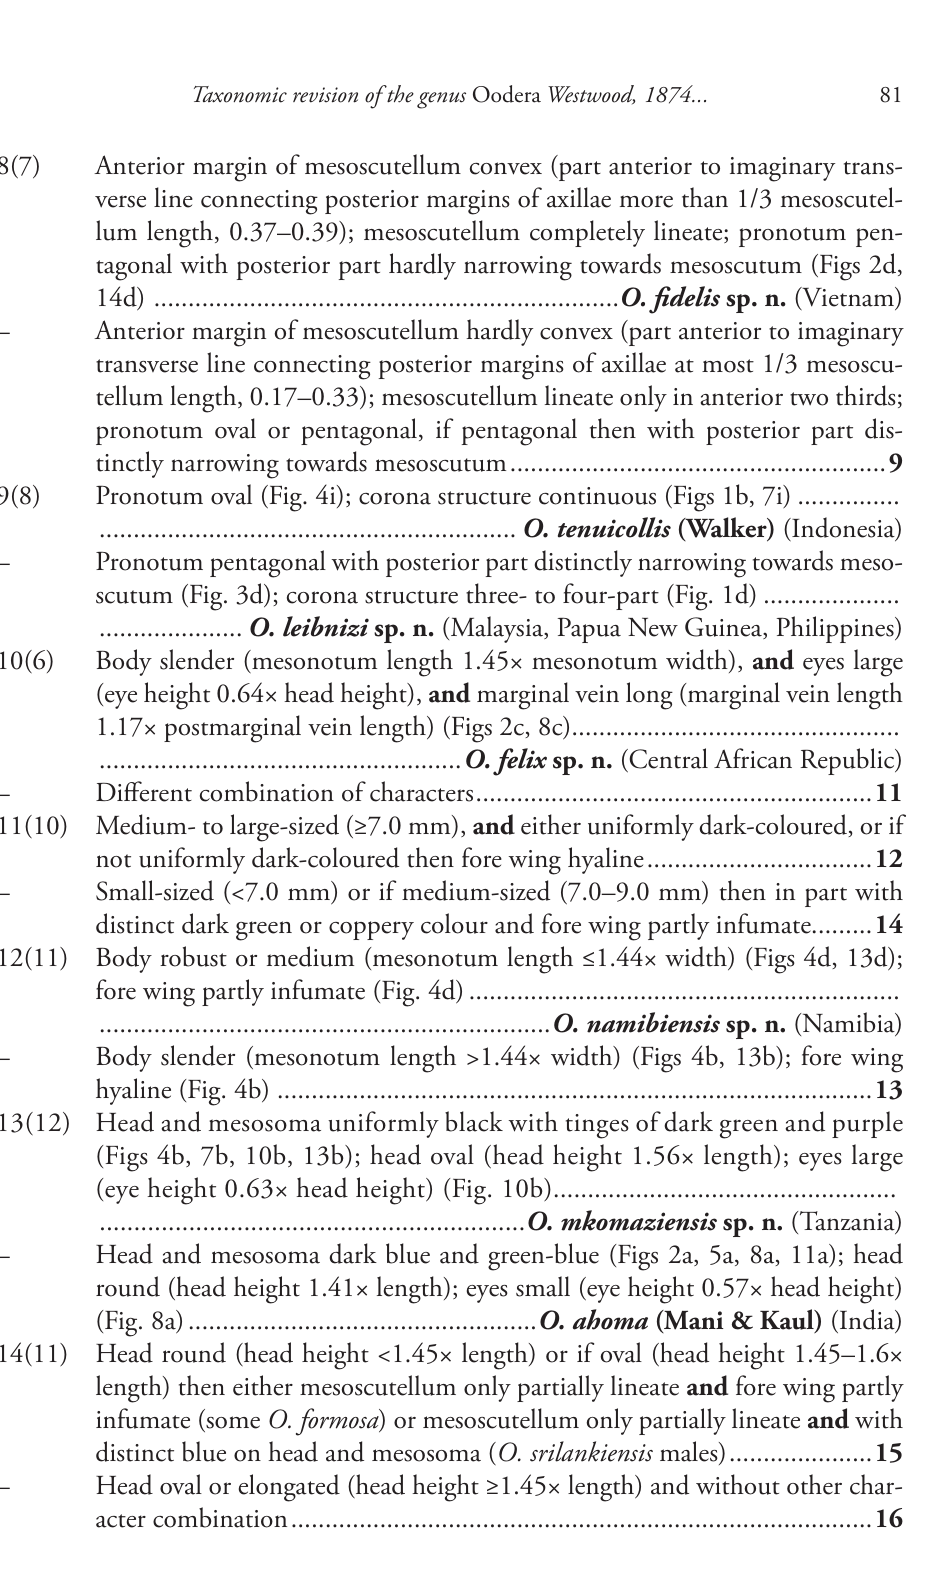
11(10) Medium- to large-sized (≥7.0 mm), and either uniformly dark-coloured, or if not uniformly dark-coloured then fore wing hyaline ................................. 12 Small-sized (<7.0 mm) or if medium-sized (7.0–9.0 mm) then in part with distinct dark green or coppery colour and fore wing partly infumate......... 14 12(11) Body robust or medium (mesonotum length ≤1.44× width) (Figs 4d, 13d); fore wing partly infumate (Fig. 4d) ............................................................... – Body slender (mesonotum length >1.44× width) (Figs 4b, 13b); fore wing hyaline (Fig. 4b) ....................................................................................... 13 13(12) Head and mesosoma uniformly black with tinges of dark green and purple (Figs 4b, 7b, 10b, 13b); head oval (head height 1.56× length); eyes large (eye height 0.63× head height) (Fig. 10b).................................................. Head and mesosoma dark blue and green-blue (Figs 2a, 5a, 8a, 11a); head round (head height 1.41× length); eyes small (eye height 0.57× head height) (Fig. 8a) ................................................... O. ahoma (Mani & Kaul) (India) Head round (head height <1.45× length) or if oval (head height 1.45–1.6× length) then either mesoscutellum only partially lineate and fore wing partly infumate (some O. formosa ) or mesoscutellum only partially lineate and with distinct blue on head and mesosoma ( O. srilankiensis males) .....................